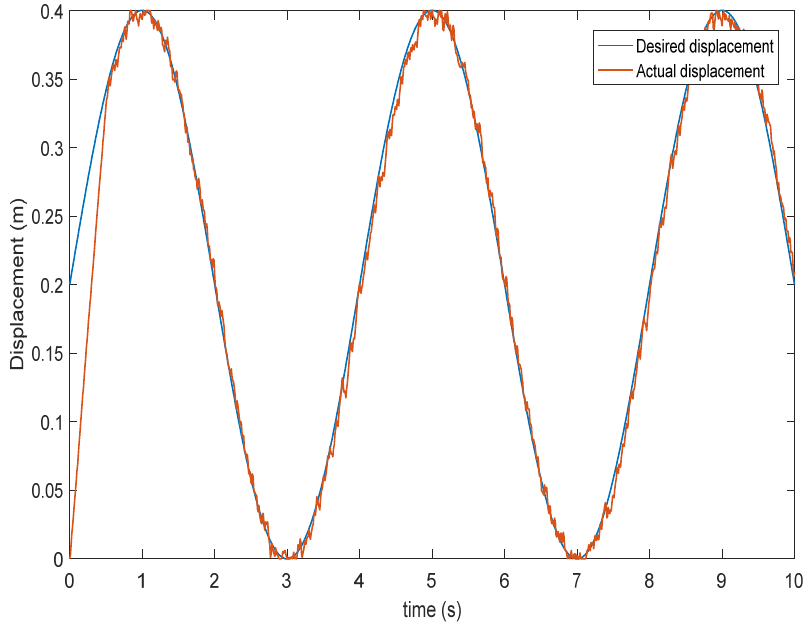
Figure 7. Displacement tracking curve of adaptive reaching law SMC algorithm after disturbed signal.